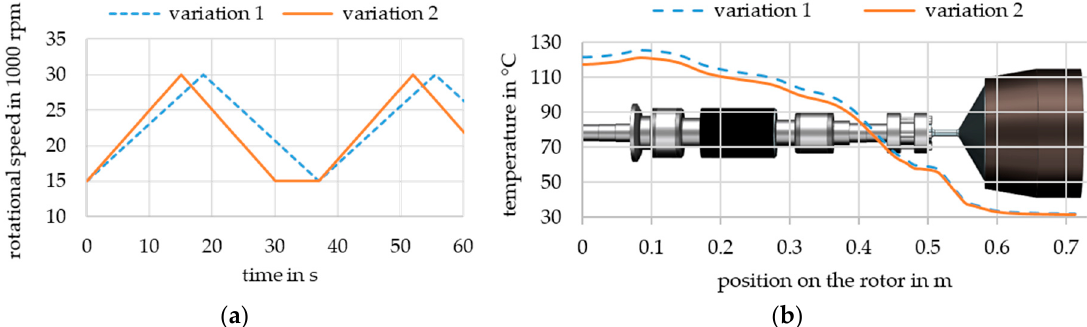
Table 4. Mean rotor losses during cycling variation 1 and 2 with a reduced bias current of 4 A.